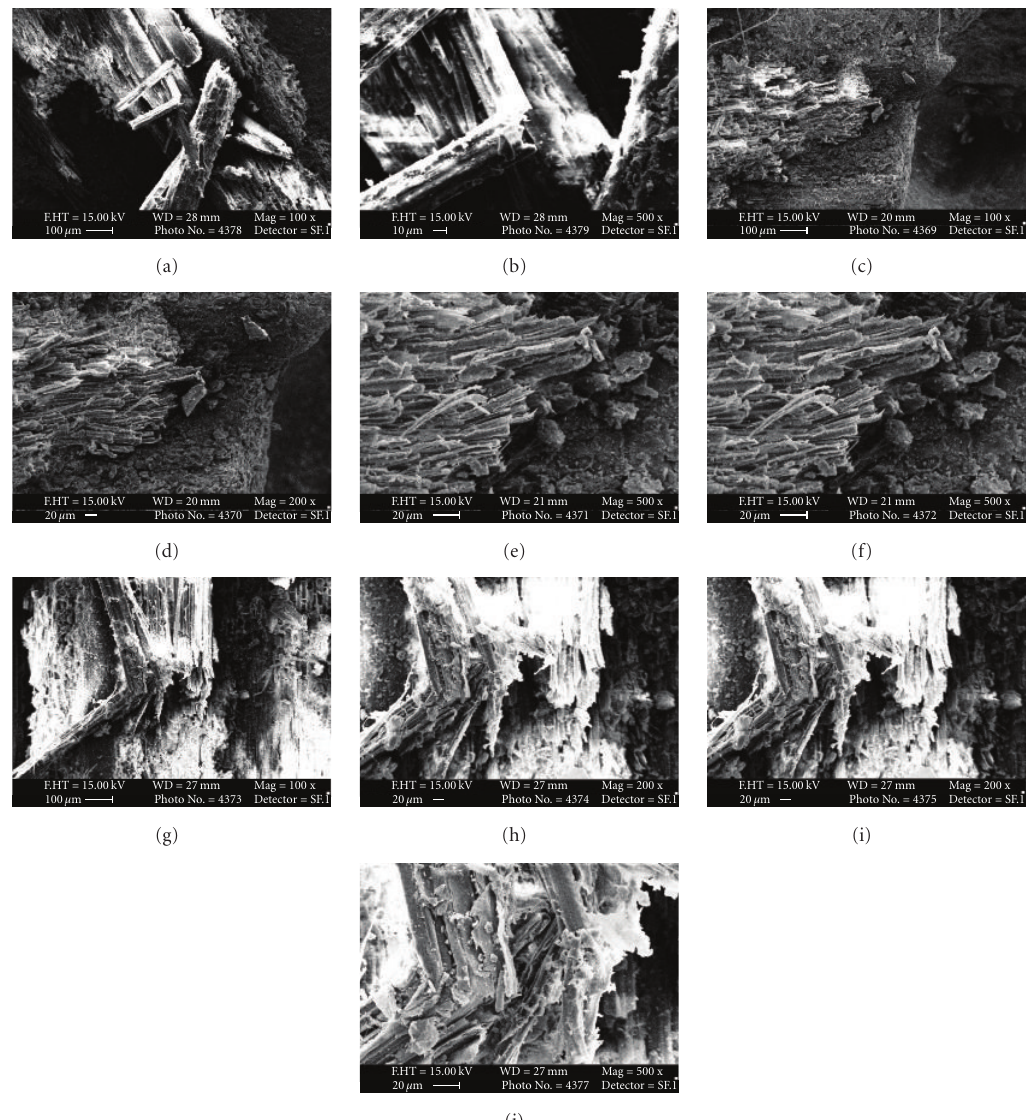
Figure 10: SEM observations of eroded samples with the variations of impact velocity.